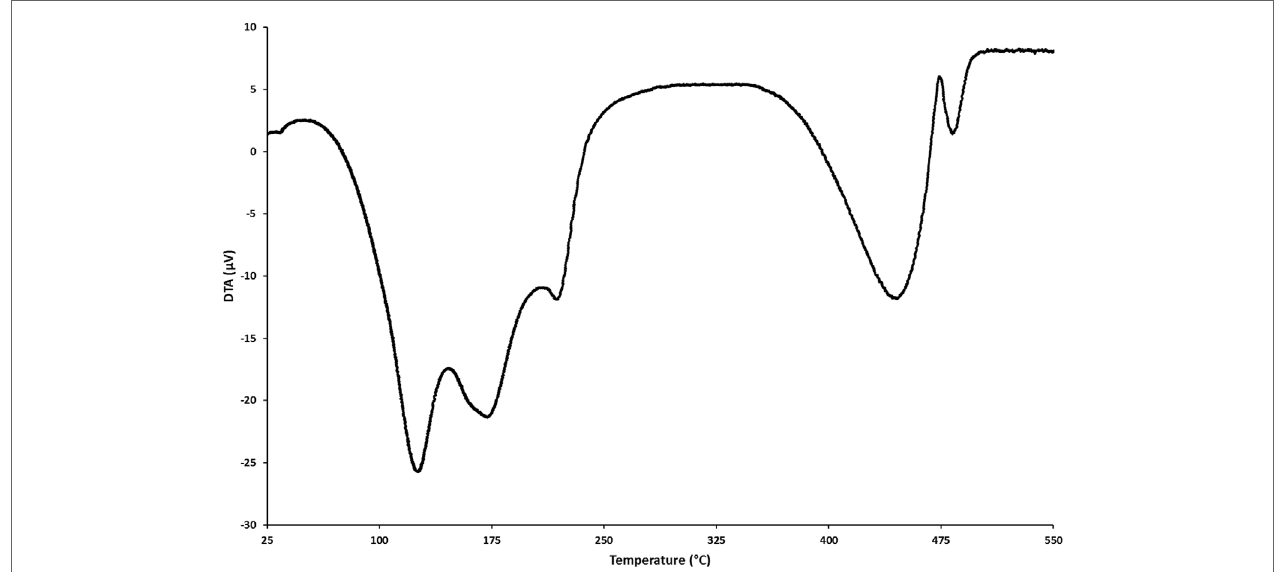
FigUre 4 | DTa pattern of nesquehonite (synthesis conditions: 25°c, 4 h, 0.2 mol of Mgcl 2 and na 2 cO 3 , total volume 1.2 l) obtained with a heating rate of 5°c min − 1 under a flowing n 2 atmosphere (55 ± 5 ml min − 1 ); sample mass was ~24 mg